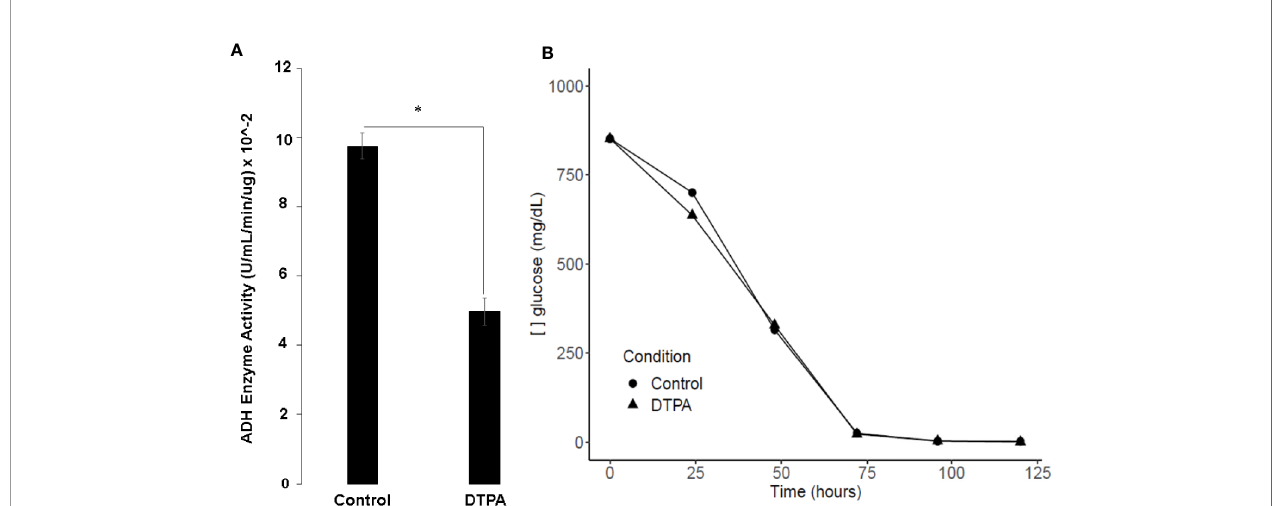
FIGURE 6 | In fl uence of zinc scarcity glucose metabolism of H. capsulatum . (A) Enzymatic activity of ADH during zinc deprivation in 24 h. (B) Glucose dosage in culture supernatants of cells grown in Zn replete or Zn depleted conditions. All experiments were carried out in biological triplicates. Student t test with *p ≤